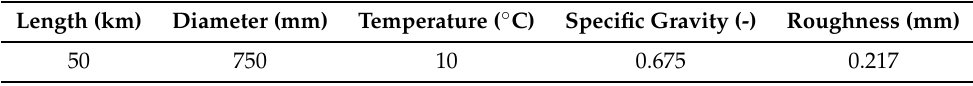
Table 2. Basic Parameters of the Pipeline in Example